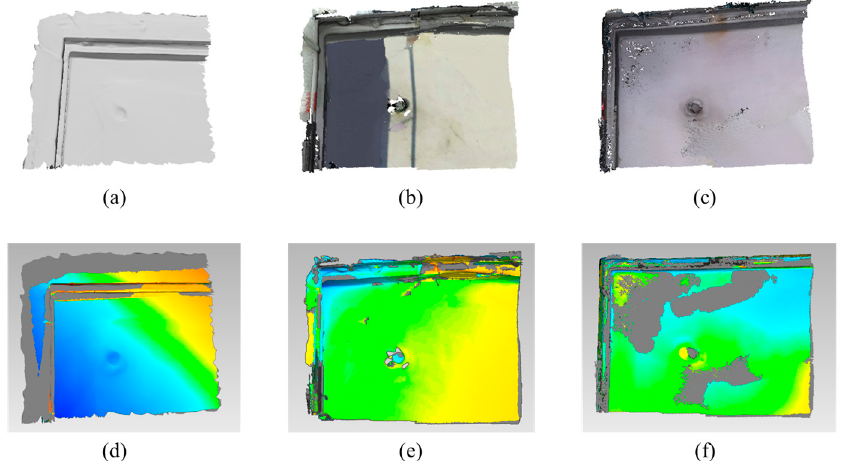
Figure 9. Reconstructed result and error analysis of outdoor scene with various methods: Recon- structed result with ( a ) ToF camera; ( b ) stereo camera; ( c ) proposed method; error analysis of ( d ) ToF camera; ( e ) stereo camera; ( f ) proposed method.